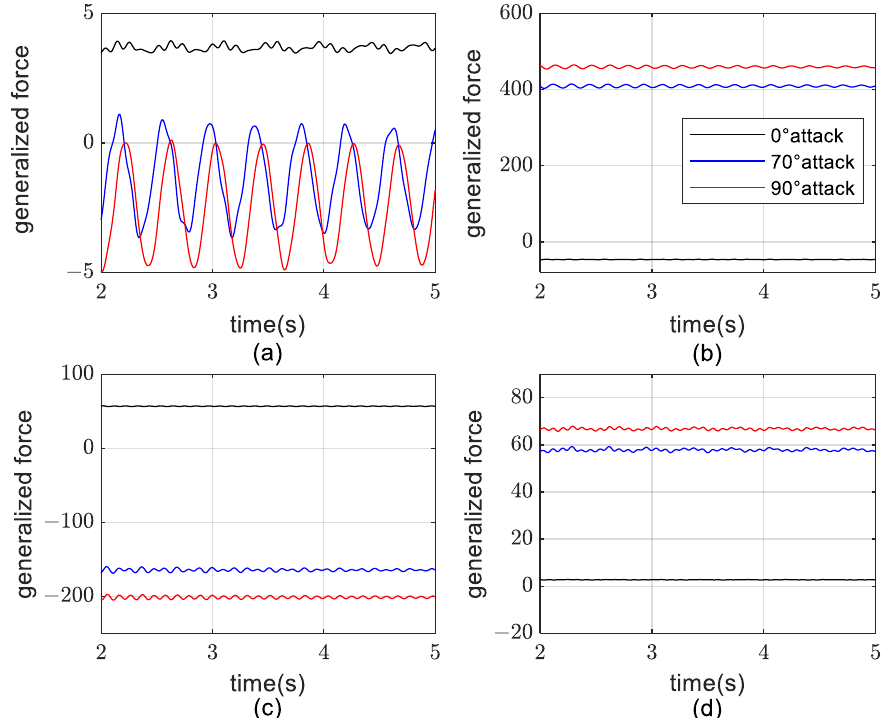
Figure 11. Curves of the generalized force–time response ( Ma = 0.5, p = 700 Pa). ( a ) First-order mode, ( b ) second-order mode, ( c ) third-order mode, and ( d ) fourth-order mode.